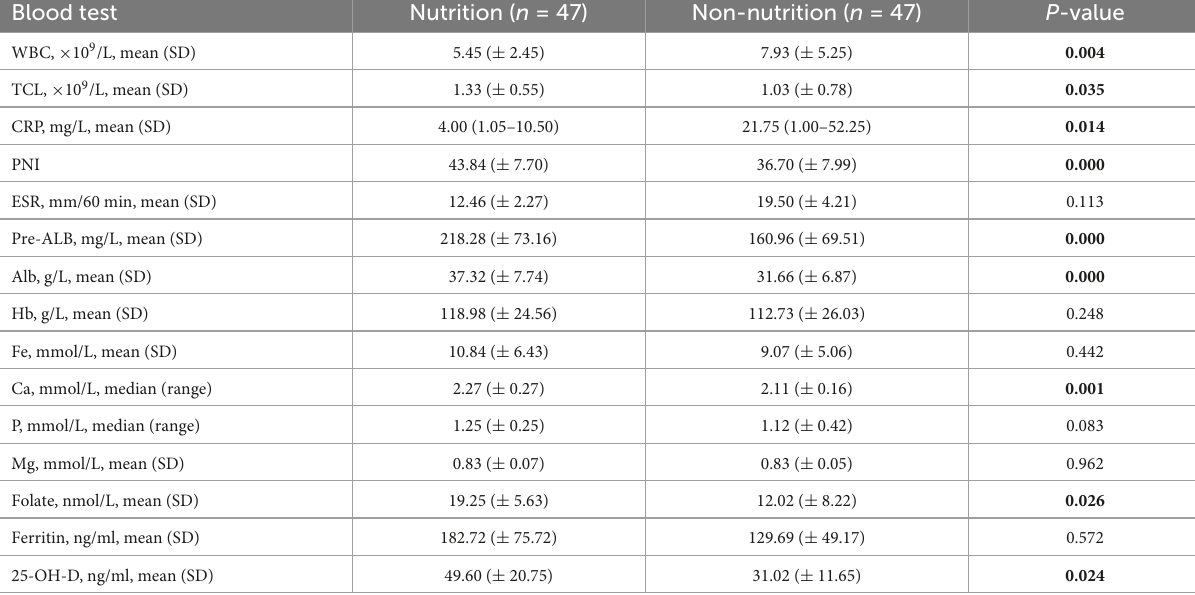
TABLE 2 Laboratorial inflammation and nutritional